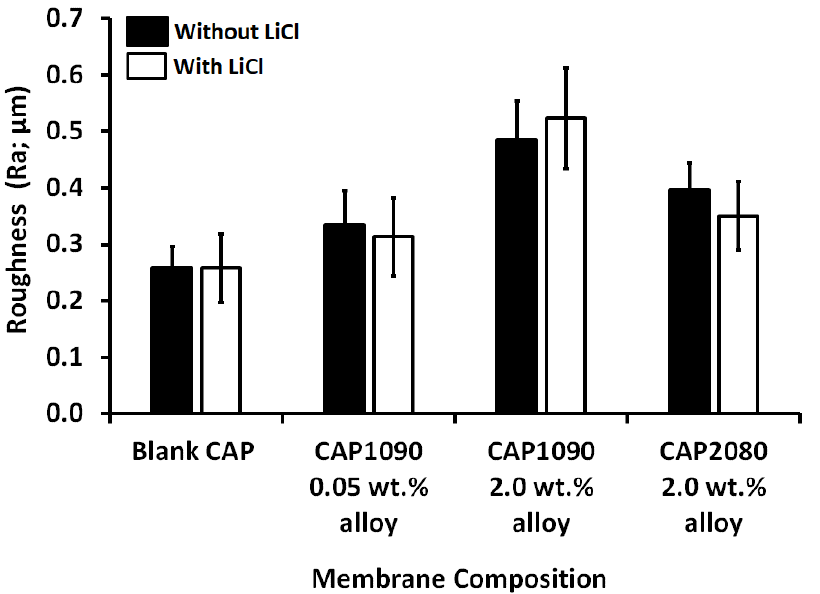
Figure 9. Membrane roughness (Ra) of both the blank CA and the magnetic mixed cellulose acetate (CA) matrix membranes as a function of membrane dope composition (wt.% alloy concentration) with the absence (black bars) and presence of 0.1 wt.% of lithium chloride (white bars). Poly(methyl methacrylate) (PMMA; 0.8 wt.%) was used in the membrane dope for all the prepared blank CA and magnetic mixed CA matrix membranes.